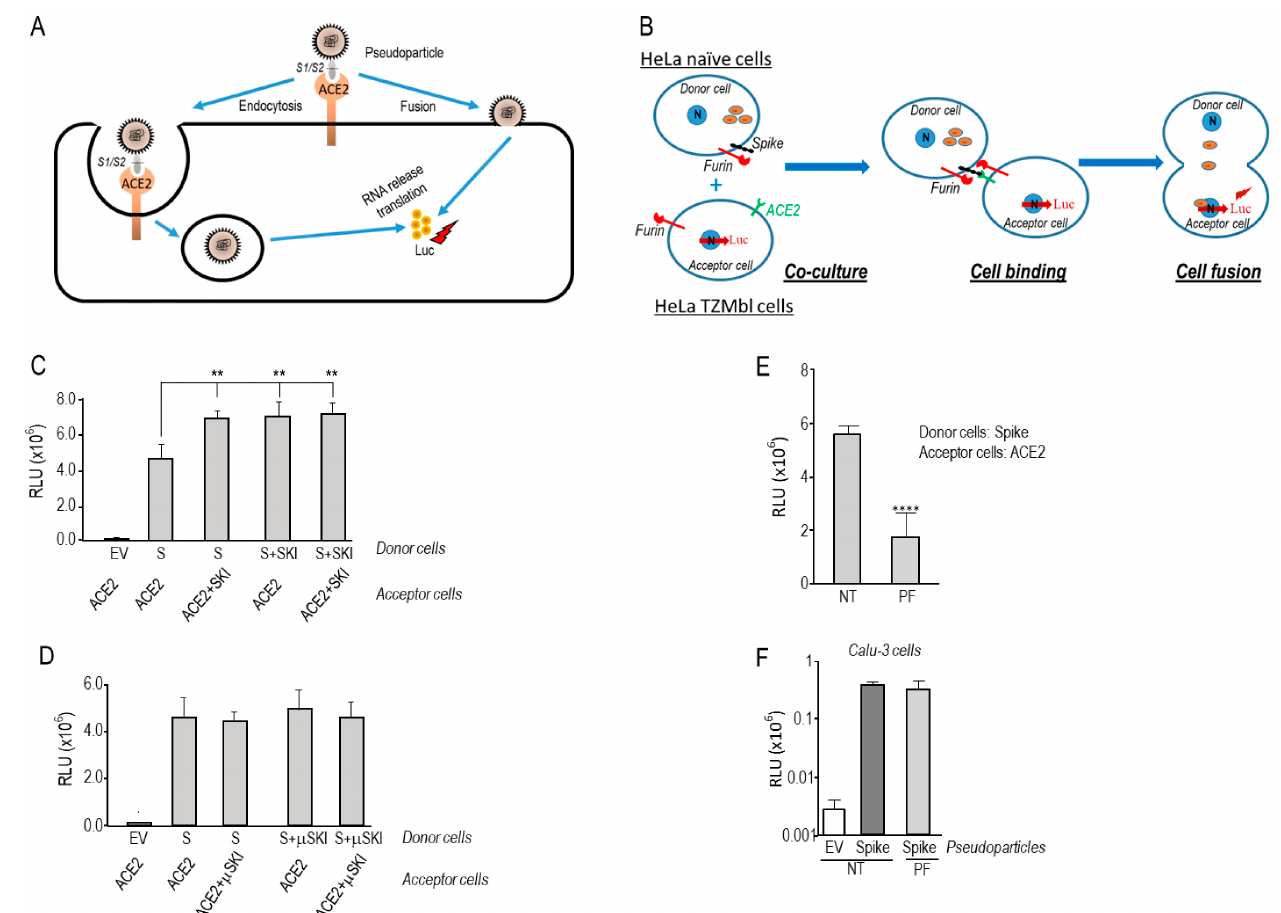
Figure 1. SKI-1 activity is required for cell-to-cell fusion in HeLa cells but not for pseudoparticle entry. ( A ) Schematic representation of pseudotyped particles’ entry into Calu-3 cells. Upon incubation of cells with nanoluciferase-expressing HIV particles pseudotyped with SARS-CoV-2 S WT, pseudoparticles can either enter the cell by endocytosis or fusion upon Spike priming and activation. After RNA release and nanoluciferase expression, the extent of fusion is quantified by measuring nanoluciferase activity. ( B ) Cell-to-cell fusion between donor cells (HeLa) expressing the SARS-CoV-2 spike protein along with the HIV trans-activator Tat, and acceptor cells (TZM-bl) that express ACE2. Upon fusion, Tat is transferred from donor to acceptor cells, thereby inducing luciferase expression. ( C , D ) Hela cells transiently transfected with an empty vector (EV) or expressing SARS-CoV-2 spike (S) (donor cells), were co-cultured for 18 h with TZM-bl HeLa cells expressing ACE2 receptor (acceptor cells). The values shown are the ( C ) WT SKI-1 or ( D ) its active site mutant ( µ SKI-1, H249A), which were expressed in acceptor and/or donor cells. ( E ) Donor HeLa cells expressing WT-S were co-cultured with acceptor TZM-bl cells expressing ACE2 in absence or presence of 10 µ M of SKI-1 Inhibitor (PF429242). ( F ) Calu-3 cells were inoculated with nanoluciferase-expressing HIV particles pseudo- typed with empty vector (EV) or SARS-CoV-2 wild-type spike (WT), in the absence or the presence of 10 µ M of SKI-1 Inhibitor (PF429242). The cell-to-cell fusion luciferase assay used throughout is detailed in the Material and Methods Section 2.4. The relative light units (RLU) were obtained using a Promega GloMax plate reader luminescence detection system. Representative data from at least three independent experiments are shown. p values (**, p < 0.01; ****, p < 0.0001) were evaluated by a Student’s t